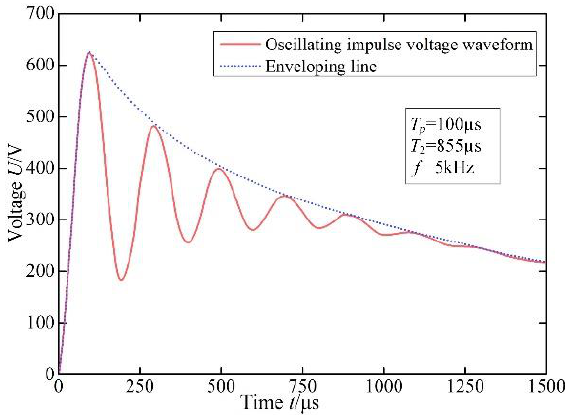
Figure 9. Oscillating switching impulse (OSI) waveform. Energies 2016 , 9 , 644